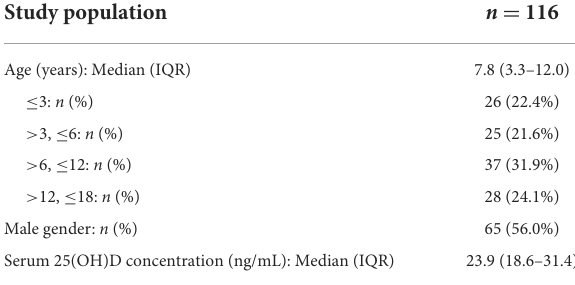
TABLE 1 Demographic characteristics of pediatric cases infected with Omicron subvariant